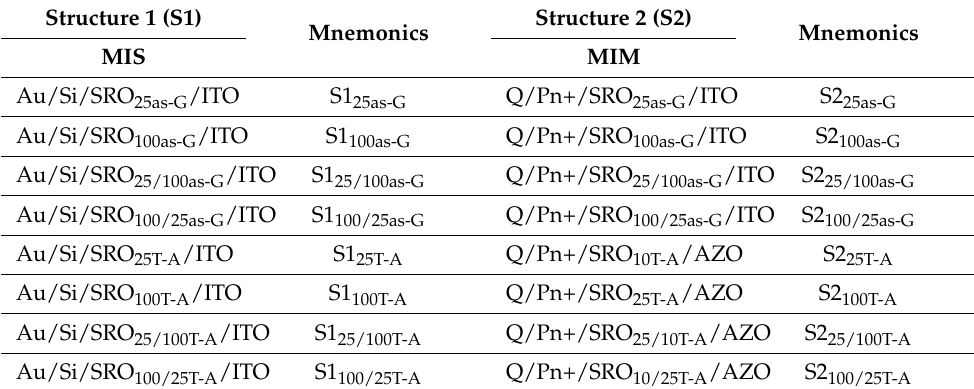
Figure 2. S1 (MIS) and S2 (MIM) structures fabricated D-L SRO films. Table 2. Metal Insulator Semiconductor and Metal Insulator Metal structures with S-L and double layer (D-L) SRO films both as-G and T-A.